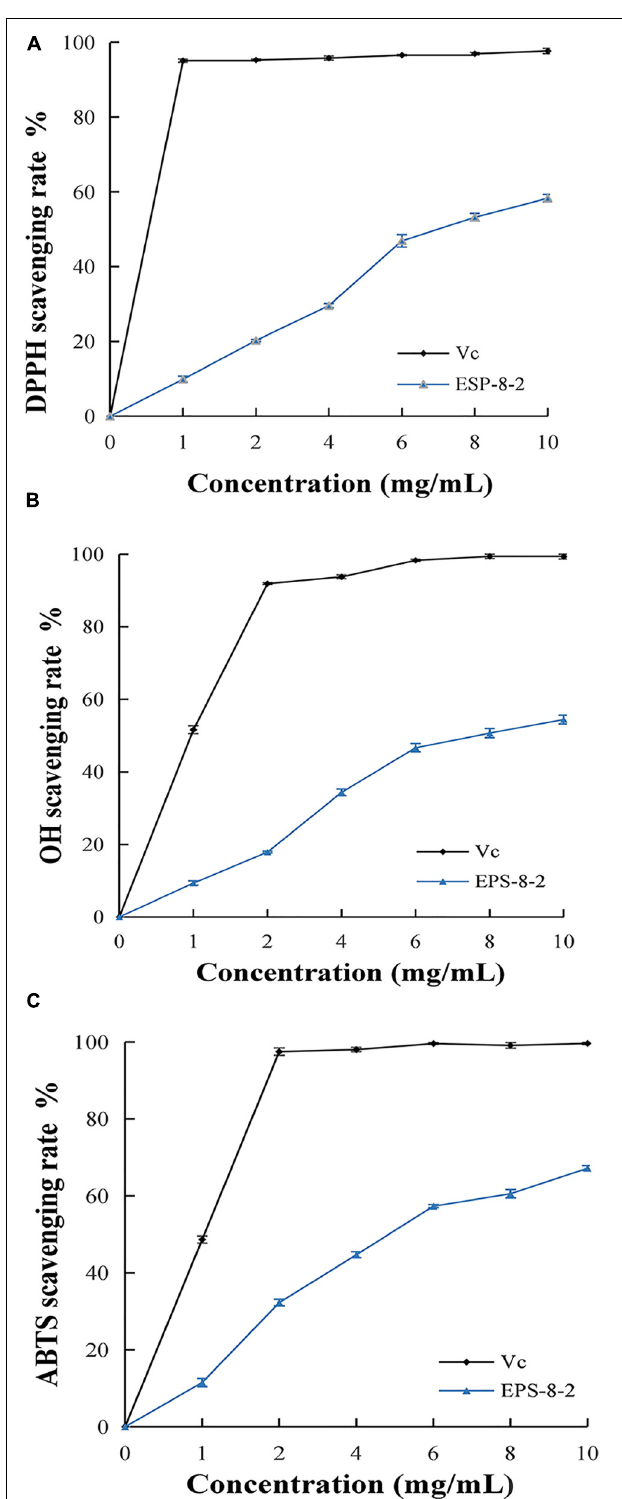
FIGURE 4 | In vitro antioxidant activity of EPS from L. mesenteroides SN-8 using ascorbic acid (Vc) as reference, respectively. (A) DPPH radical scavenging ability; (B) hydroxyl radical scavenging ability; (C) ABTS radical scavenging activity.